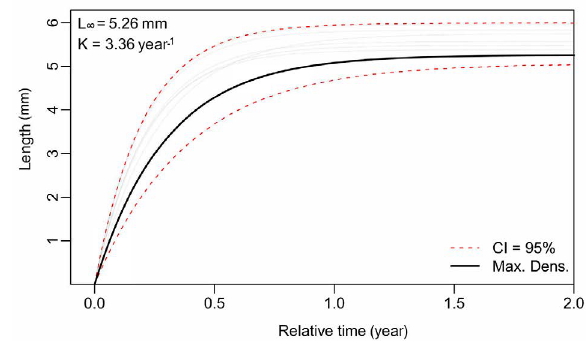
Fig. 6. – Von Bertalanffy growth curve and parameters for Chondrochelia dubia (pooled sexes). CI=95% confidence